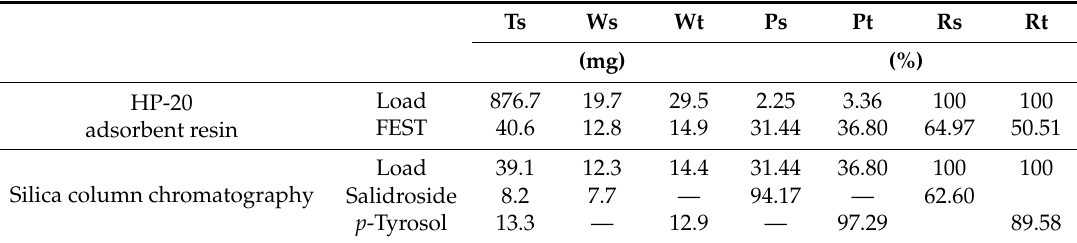
Silica column chromatography